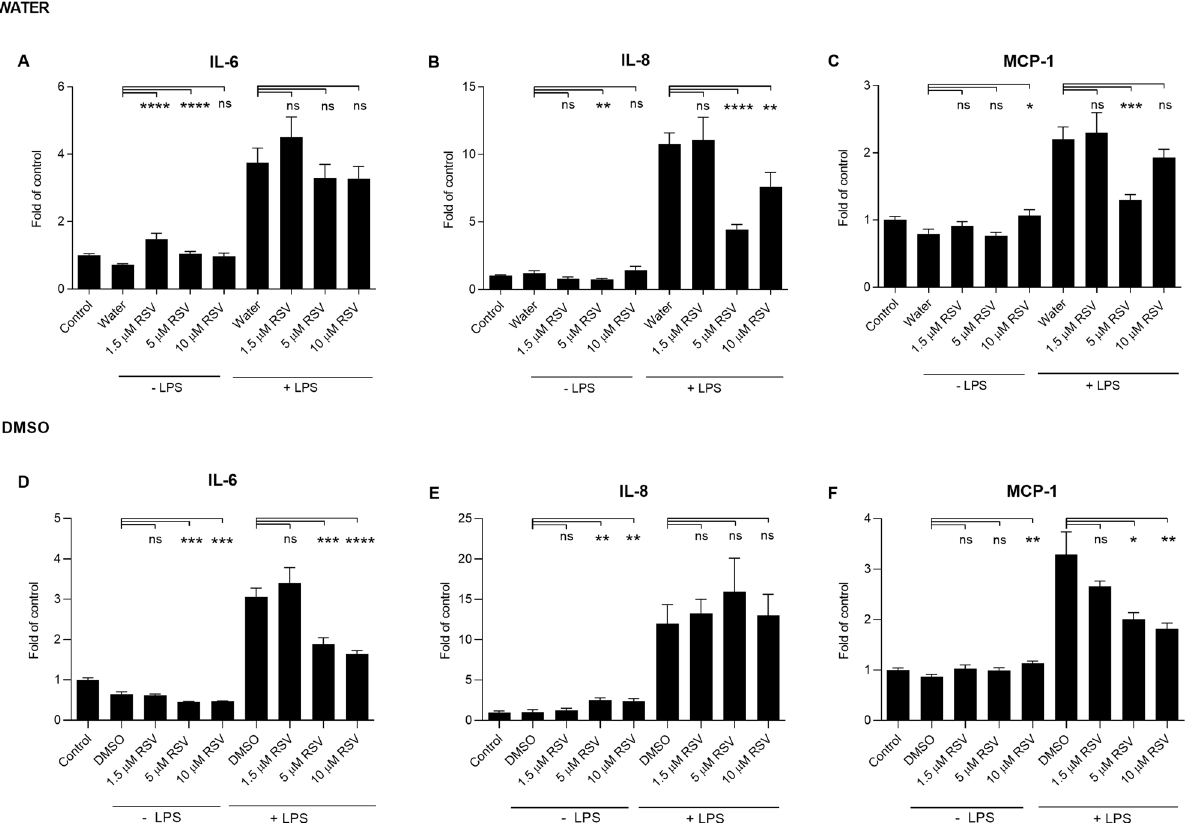
Figure 4. The effect of rosuvastatin (RSV) on the production of pro-inflammatory cytokines in human RPE cells at 48 h incubation. The levels of IL-6, IL-8, and MCP-1 were measured following the exposure of RSV dissolved in water ( A – C ) or DMSO ( D – F ) with or without additional exposure to LPS for 24 h. The results are represented as fold of control, which was set to be 1. Results are combined from 4 independent experiments with 4 parallel samples per group in each experiment ( A – C ) and from 3 independent experiments with 4 parallel samples per group in each experiment ( D – F ) and shown as mean ± SEM. *P < 0.05, **P < 0.01, ***P < 0.001, ****P < 0.0001, ns not significant, Mann–Whitney U